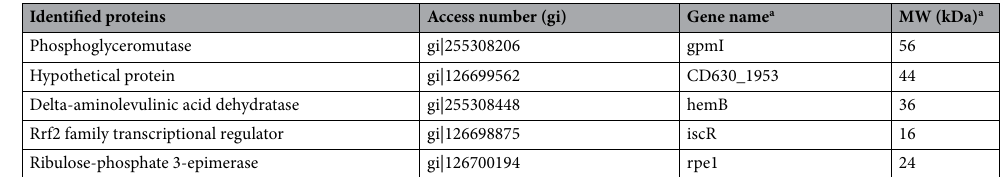
Table 1. Proteins secreted exclusively by Clostridioides difficile ICC-45 strain. a Functional annotations were taken from the Swiss protein database (https:// www. unipr ot.